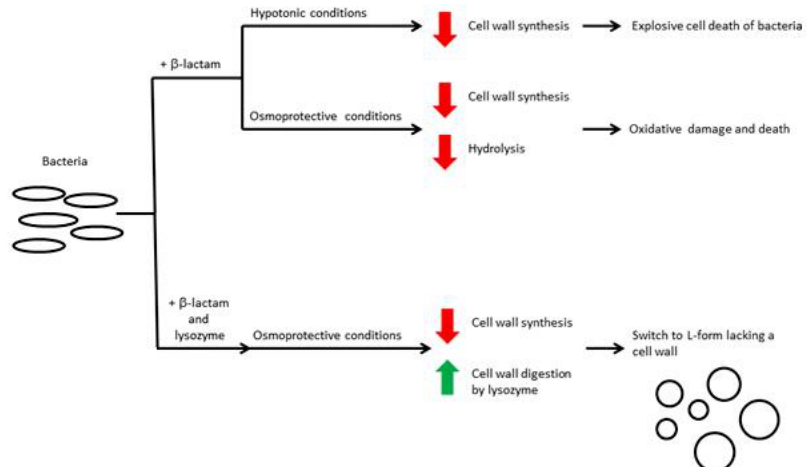
Figure 5. Various fates of bacteria upon β -Lactam